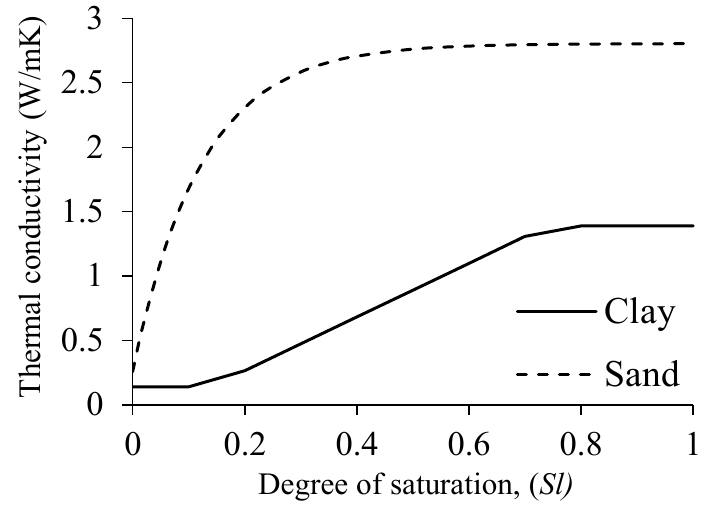
Figure 3. The thermal conductivity and degree of saturation relationships for sand and clay (after Singh [33]).